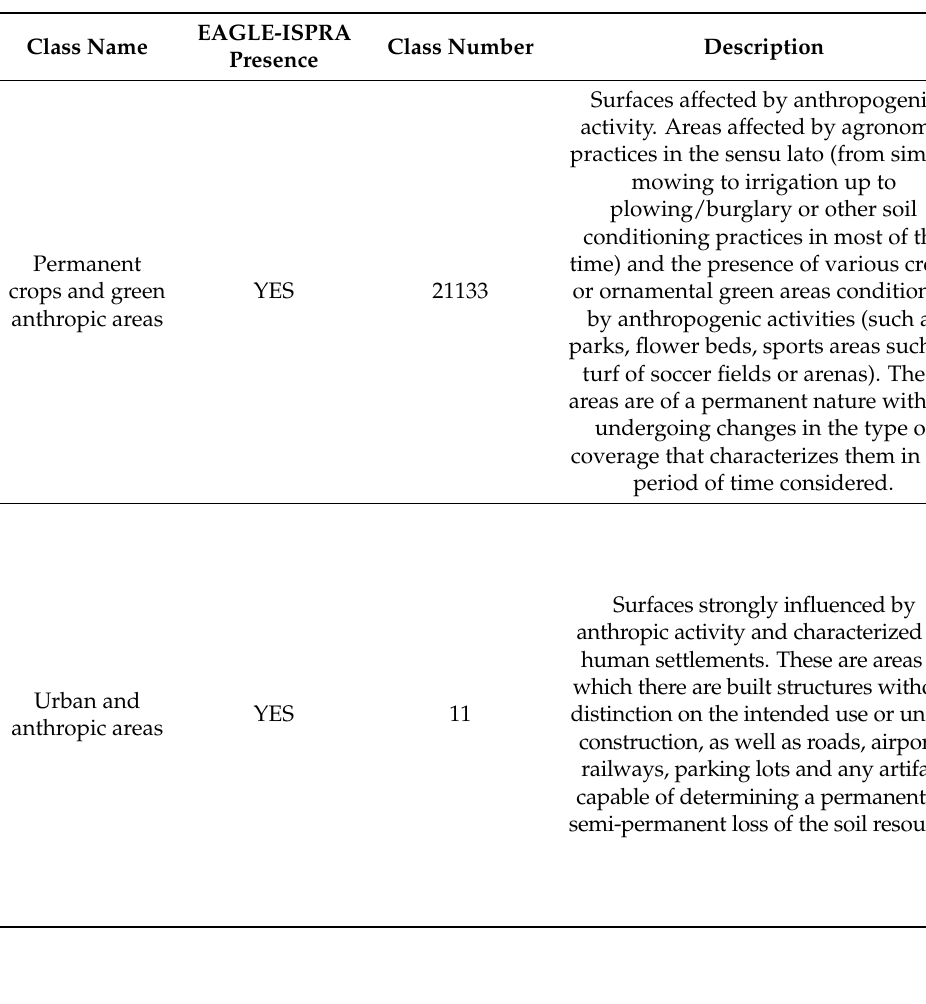
Table A1. Land cover